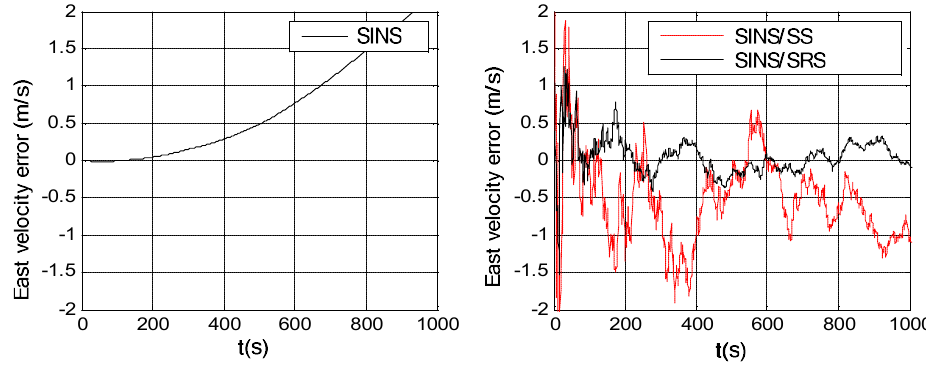
Figure 7. East velocity errors of SINS as well as SINS/SS and SINS/SRS integrated subsystems.